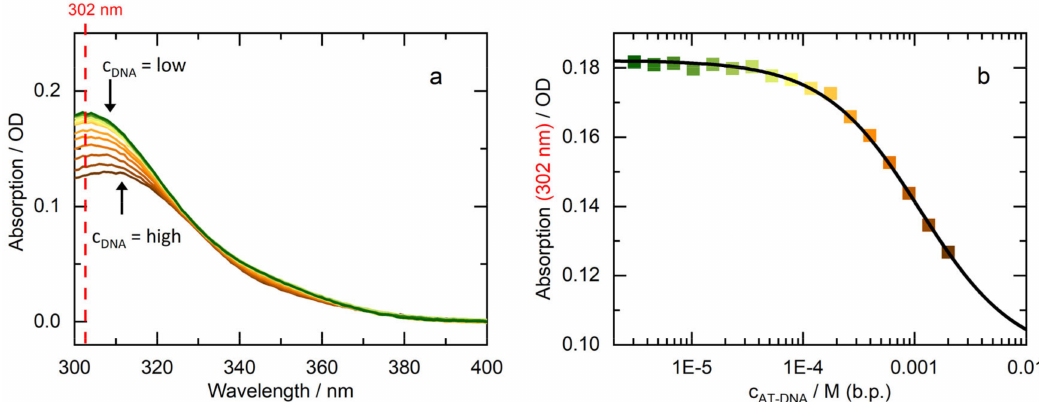
Figure 1. Intercalation behavior of 8-MOP: ( a ) UV / Vis absorption spectra of 8-MOP (15 µ M) with increasing concentration of AT-DNA in phosphate-bu ff ered saline (PBS). The contribution of DNA to the absorption was subtracted; ( b ) Absorption at 302 nm versus the concentration of AT-DNA. A fit yields the dissociation constant K D of 1.1 × 10 − 3